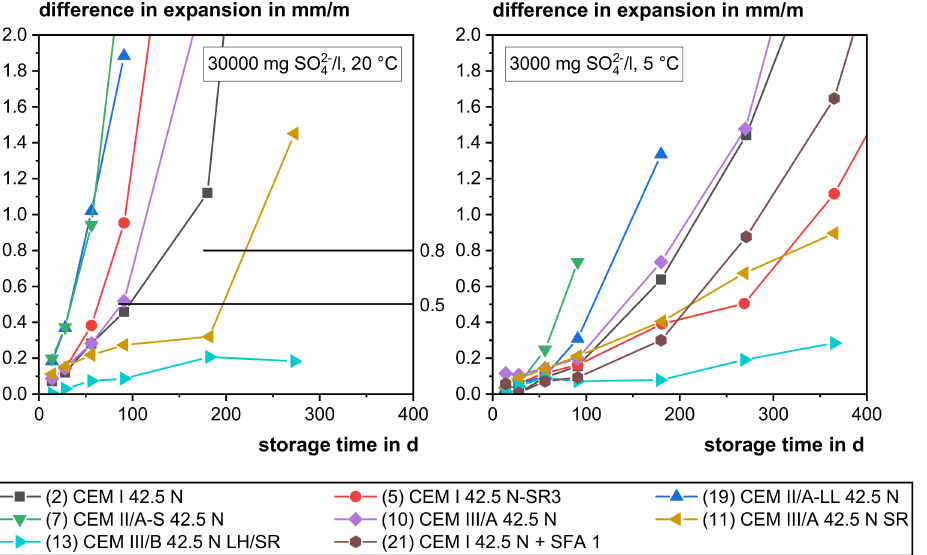
Figure 1. Exemplary results for the difference in expansion over time determined by the SVA test method: 30,000 mg SO 42 − /L and 20 ◦ C ( left ) and 3000 mg SO 42 − /L at 5 ◦ C ( right